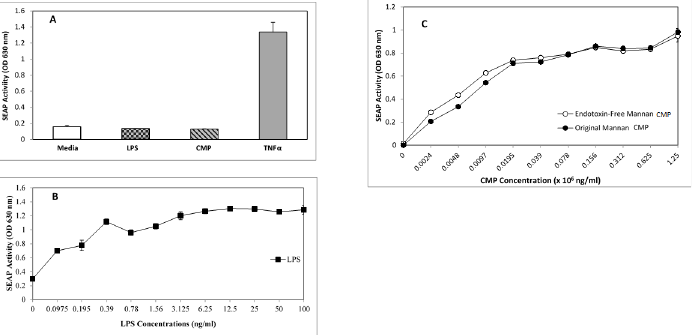
Fig 2. CMP activatesTLR4 reporter cells in a dose-dependent manner. HEK-Nullreporter cells lacking TLR4 (A) were unresponsive to media (clear bar) or stimulationwith TLR4 ligands(LPS, checked bar and CMP, striped bar); however,TNF α treatment (positive control, gray bar) significantly activated NF- κ B- dependent SEAP responses in the HEK-Null reporter cells. HEK-TLR4 reporter cells treated overnightwith a range of LPS (B) concentrations reacheda plateauof SEAP activity at 6.25 ng/ml LPS (closed squares). CMP stimulationof TLR4 reporter cells (C) was dose dependent and was not sensitive to LPS-depletion with polymyxin B; LPS-depleted CMP (open circles) or non-depleted CMP (closedcircles). Control wells (designated by 0 on the X axis) were treated with completemedia in the absenceof TLR4